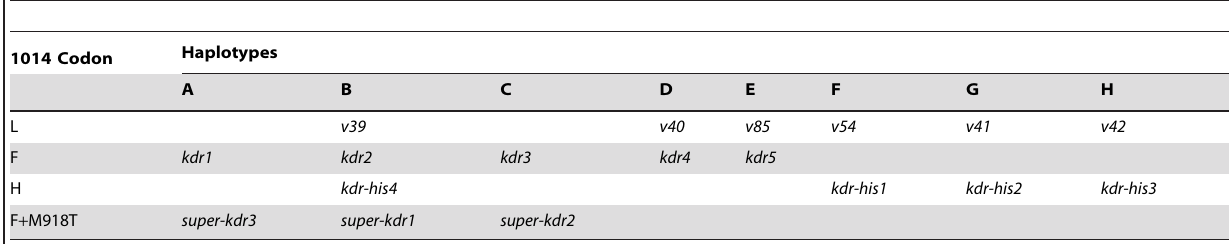
Table 1. Vssc haplotypes found in house fly populations that share the same intron